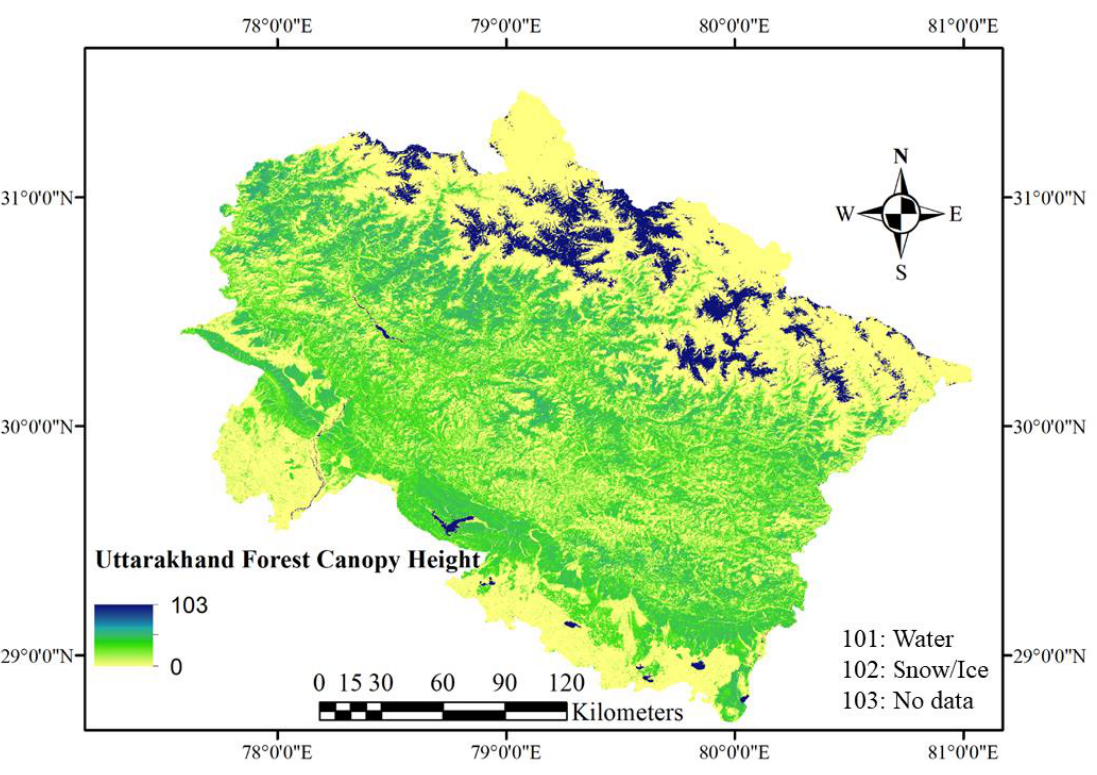
Figure 4. The 30 m spatial resolution global forest canopy height map of Uttarakhand, India.